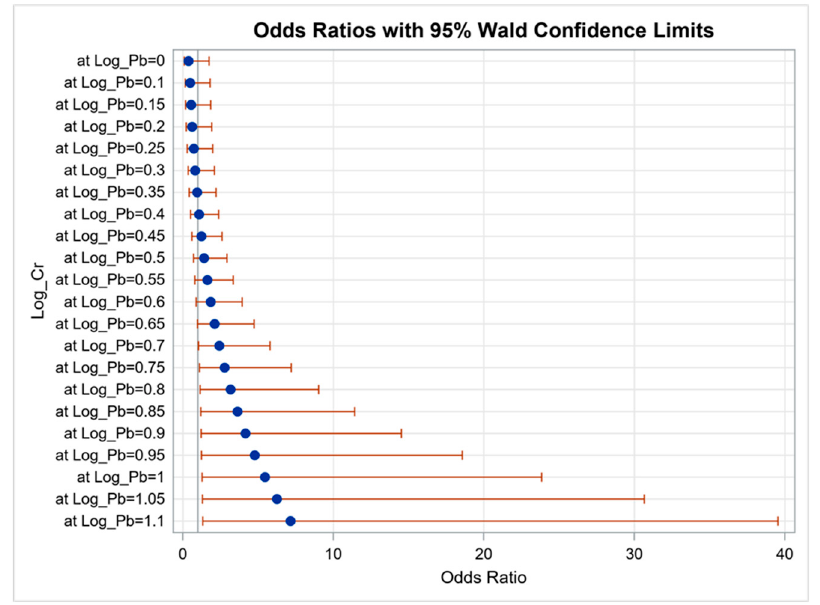
Figure 1. Synergistic effect of blood Pb and urine Cr on proteinuria. The interaction between blood Pb and urine Cr on proteinuria was statistically significant ( p = 0.047).